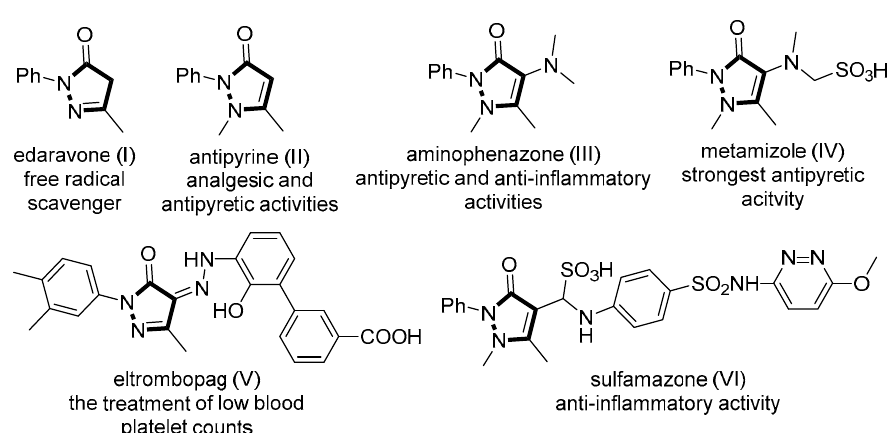
Figure 1. Representatives of bioactive dinitrogen-fused heterocycles (I – IV).